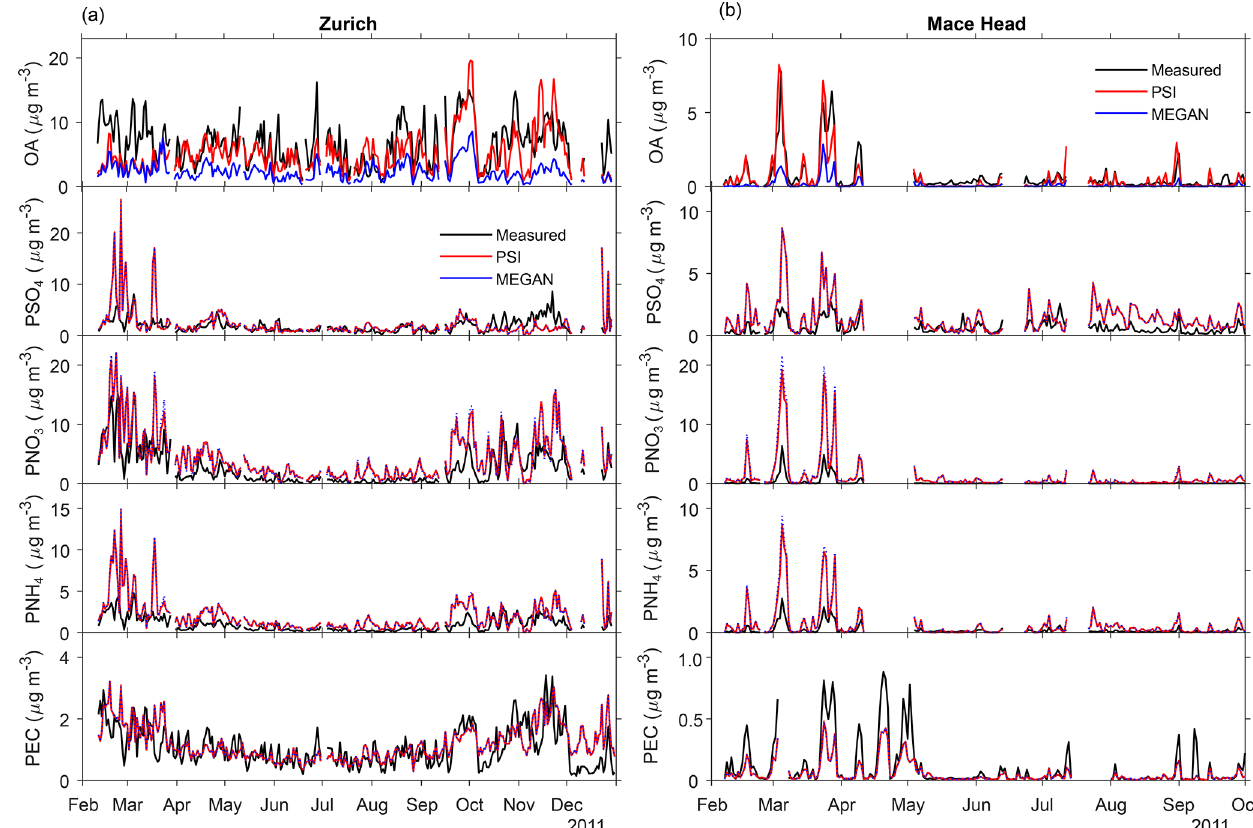
Figure 8. Temporal variation in the modelled (with both PSI and MEGAN emissions) and measured concentrations of organic and inorganic aerosols at Zurich (a) and Mace Head (b) in